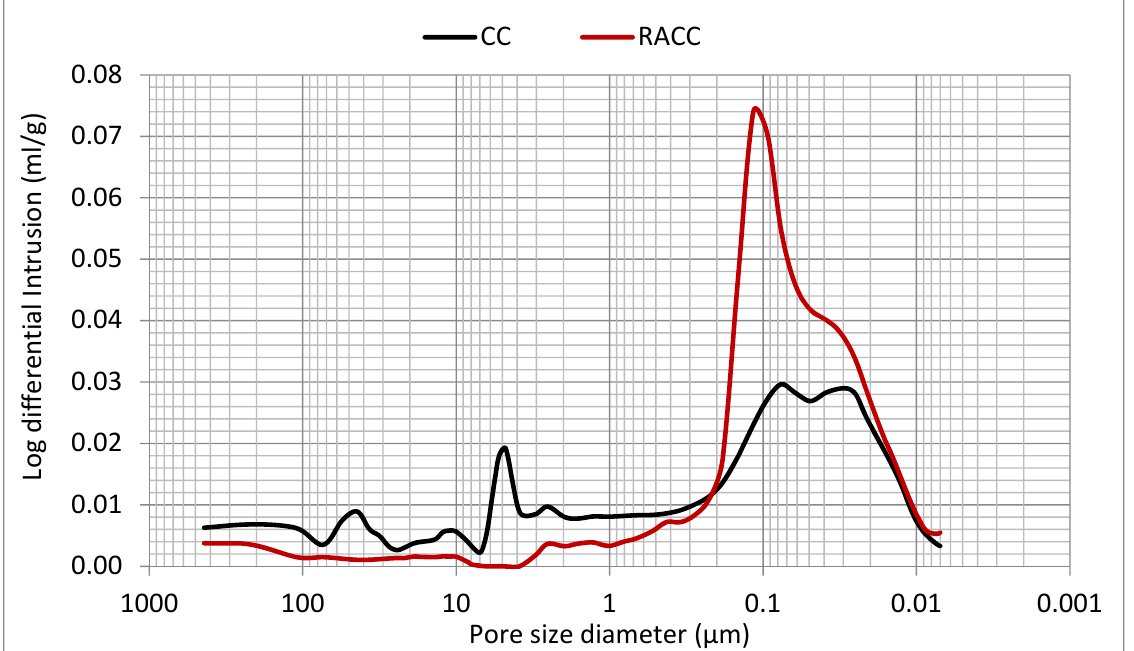
Figure 10. Pore size distribution—Log differential intrusion in 28 d CC and RACC samples.